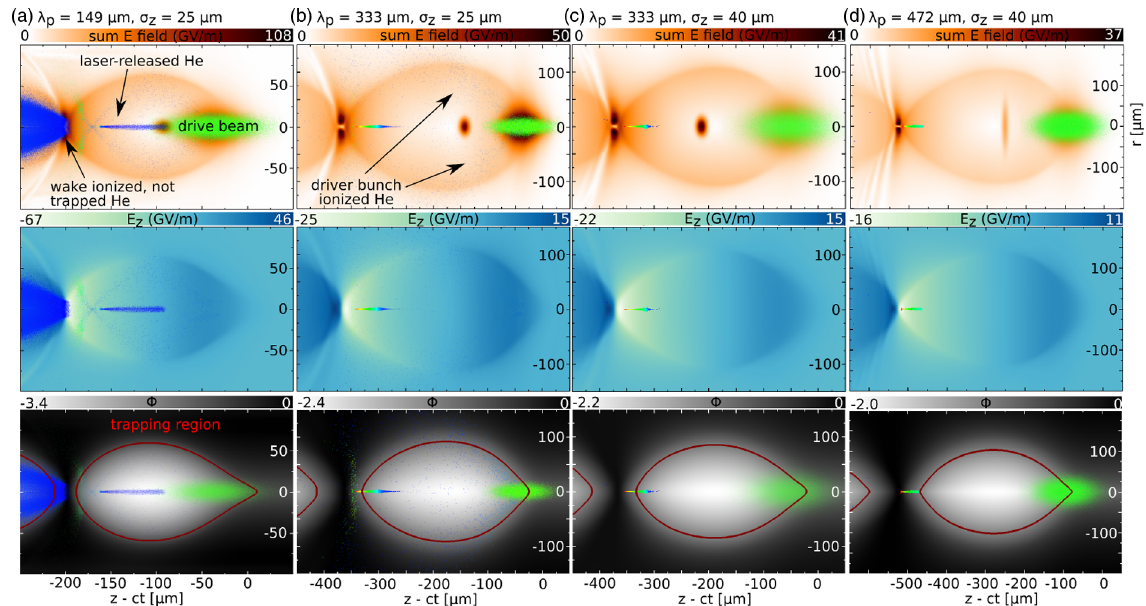
FIG. 3. PIC simulation results showing step-wise reduction of dark current formation processes in controlled laser injection PWFA. Plots in the top row show the vector sum of the electric field, while those in the middle row show the longitudinal electric fields E z , and those in the bottom row show the potential Φ . All snapshots are taken approximately at the onset of the laser release. The green shade is the drive beam, propagating to the right, the ionization-released He electrons released by lensing drive beam, injector laser and by the blowout wake hot spot are shown color coded (red: high energy, blue: low energy), and the red solid ellipse in the bottom row is the estimated trapping isoregion ( Φ ¼ − 1 . 0